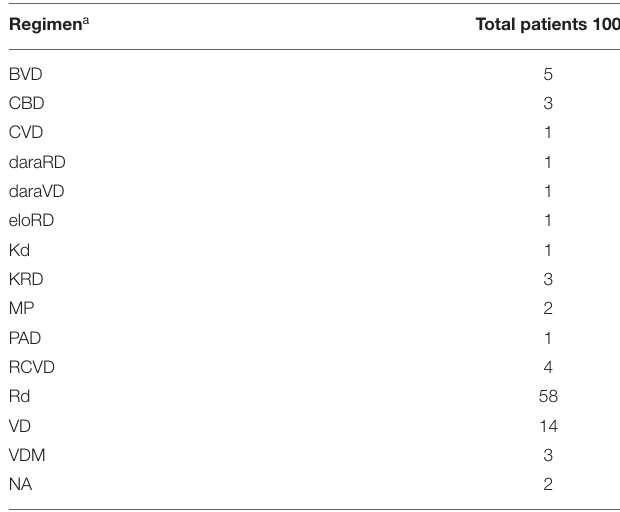
TABLE 3 | Second-line